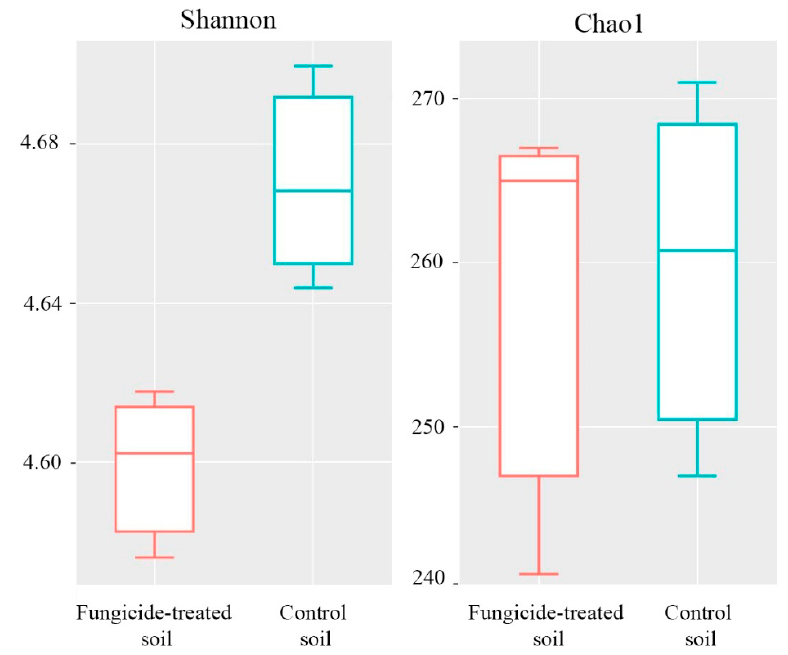
Figure 3. Box plots of the Shannon and Chao1 alpha-diversity indices of bacterial communities for the fungicide-treated and the control soils. The data represent means of three replicate sequencing reactions. Statistical analysis was performed using the Mann–Whitney test.